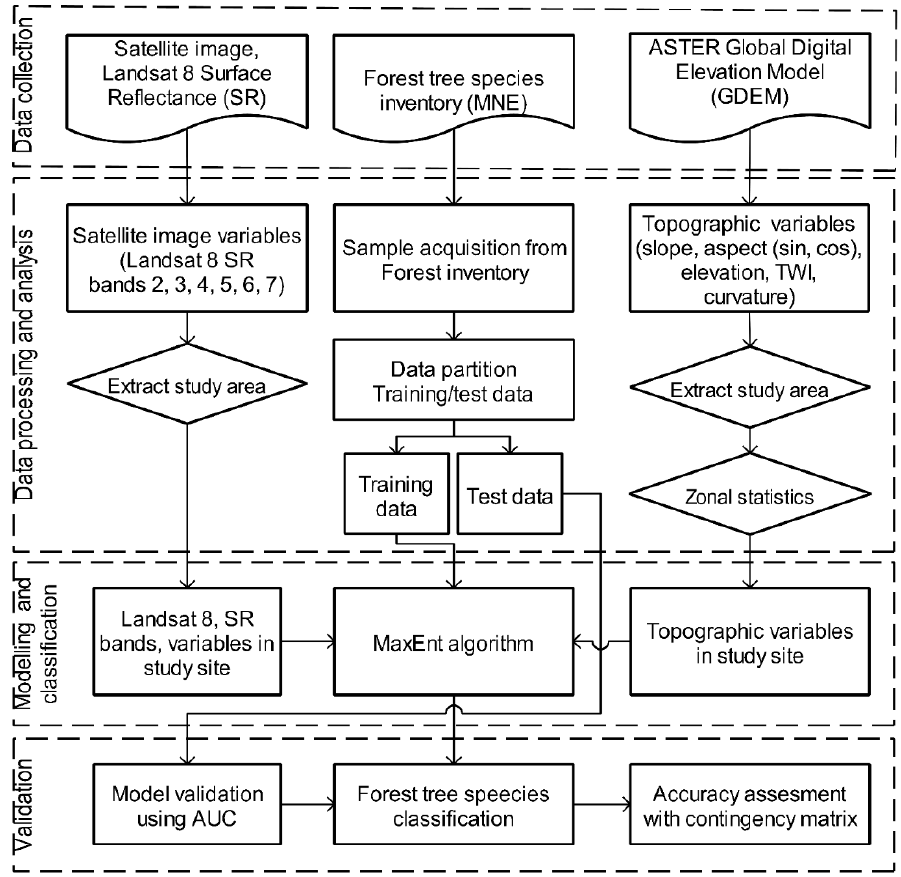
Figure 2. Methodology framework of the study.